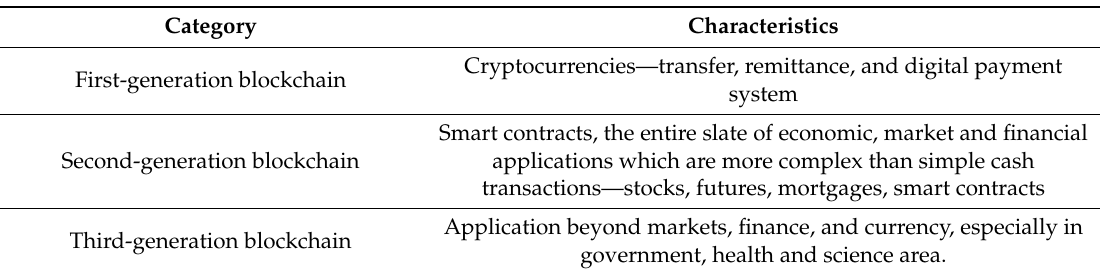
Table 2. Blockchain categories